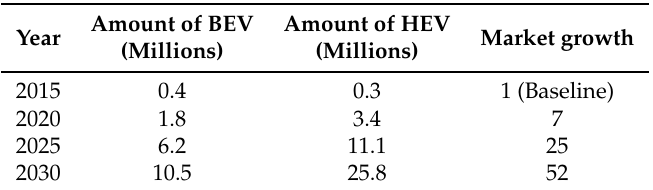
Table 8. BEV and EV market growth.